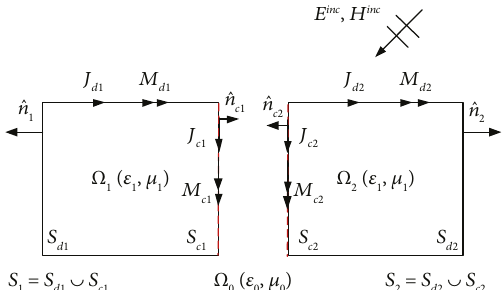
Figure 2: The model for the continuity of the currents at the contact surface.